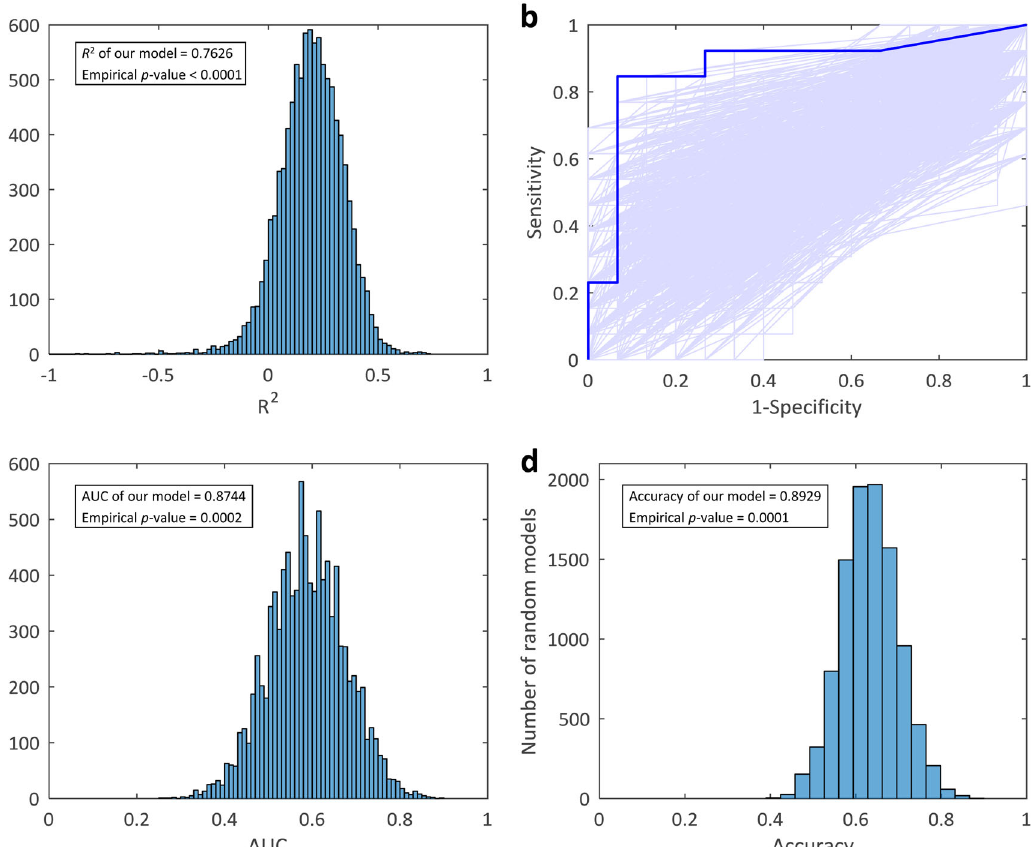
Fig. 3 Performance veri fi cation using 10,000 random models. a Empirical distribution of R 2 between the estimated and actual mutation load for 10,000 random models. b ROC curves for the constructed model and 10,000 random models. Blue line, the ROC curve of classi fi er based on the mutation load estimation model. c Empirical distribution of AUC statistic for 10,000 random models. d Empirical distribution of the classi fi cation accuracy for 10,000 random models